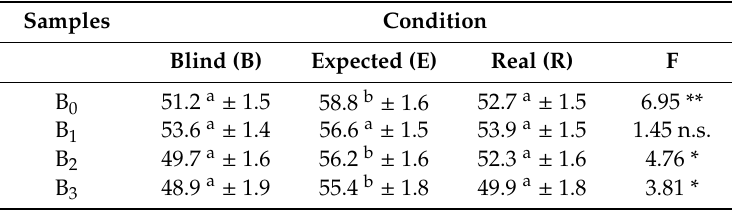
Table 4. Mean liking scores provided for each beetroot sample in the three di ff erent conditions. Di ff erent superscript letters in a row indicate significant di ff erences according to post hoc test.